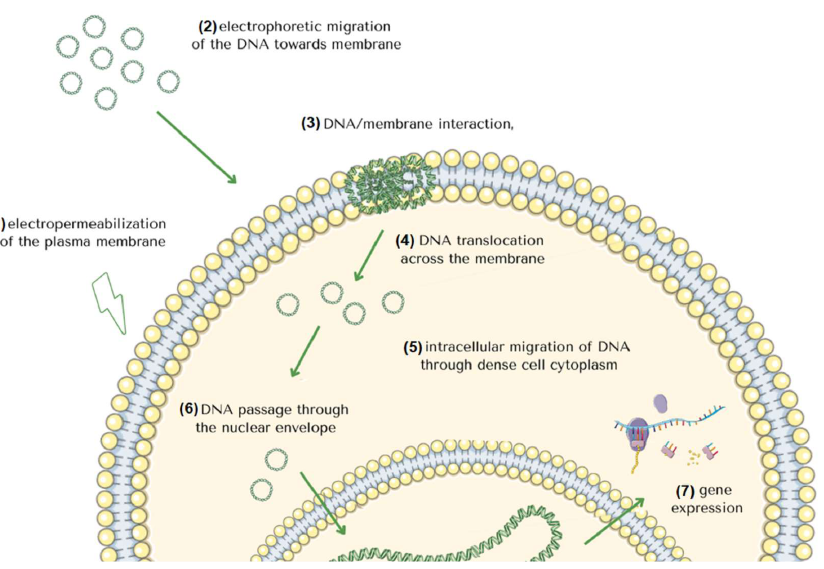
Figure 2. The chain of events that take place while inserting plasmid DNA into the cell to provoke 2 gene expression. Once the plasma membrane is subjected to electropermeabilization, DNA elec- trophoretically migrates toward the membrane and interacts with it. DNA is translocated to the cytoplasm and migrates to the nucleus, leading to the expression of particular genes [12,14,19]. The Figure was partly generated using Servier Medical Art, provided by Servier, licensed under a Creative Commons Attribution 3.0 unported